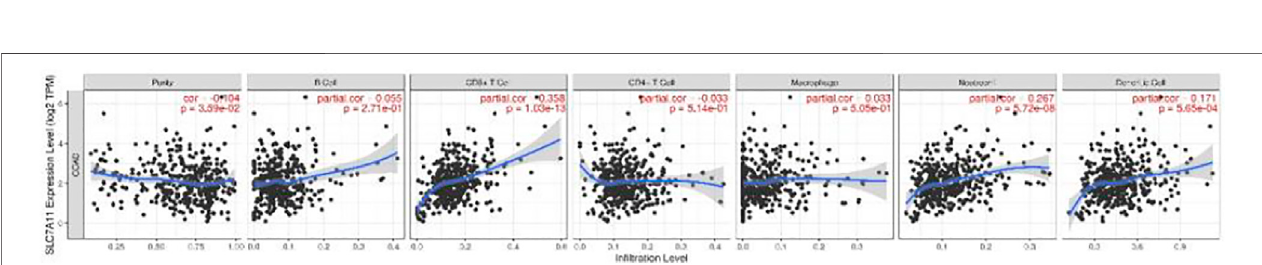
Frontiers in Molecular Biosciences |